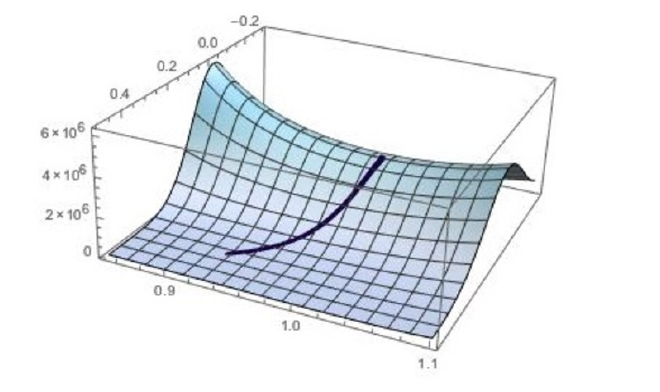
Figure 2 . A close-up of the j -in(cid:13)ation potential in the neighborhood of (cid:28) = i . The curved path indicates an N (cid:3) = 60